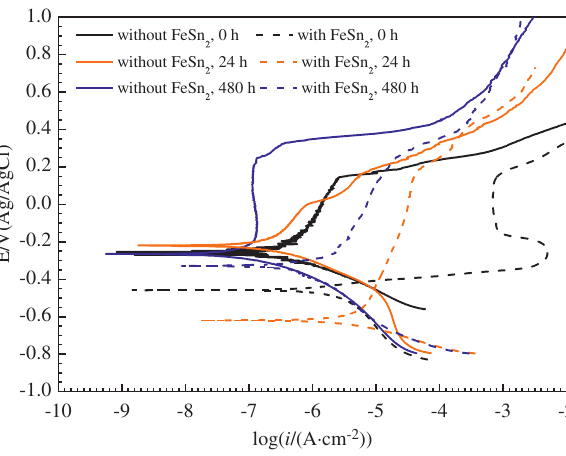
Figure 7: Potentiodynamic polarization curves in 3.5% NaCl solution for stainless steel with and without (Fe, Cr)Sn 2 after exposure to 300°C water for 24 h, 360 h, and 480